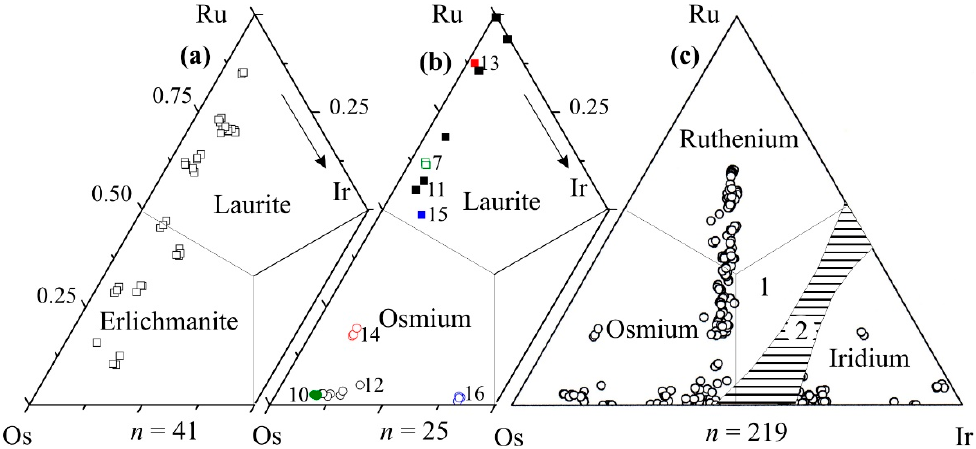
Figure 7. Chemical composition of: ( a ) Ru-Os sulfides type 1, ( b ) coexisting laurite type 2 and Os-rich alloy grains, ( c ) Ru- Os-Ir alloys from the Verkh-Neivinsk massif in coordinates Ru-Os-Ir (at.%). Numbers 7–16 in Figure 7b correspond to the same numbers of electron microprobe analyses in Tables 1 and 2. Squares and circles refer to laurite and Os alloy, respectively. Different symbol colors denote laurite–alloy pairs shown in Figure 3c,f and Figure 6. Numbers 1 and 2 in Figure 7 c correspond to rutheniridosmine and miscibility gap, respectively (after nomenclature of Harris and Cabri [79]). Os-Ir-Ru alloys from the primary PGM assemblage of Verkh-Neivinsk are dominated by native osmium, ruthenium, and iridium (Figure 7c). The variation of osmium and ruthenium concentrations are due to the substitution by iridium in the solid solution of osmium (the trend of compositions along the horizontal axis Os-Ir in Figure 7c) or ruthenium (vertical trend of compositions towards Ru, Figure 7c).